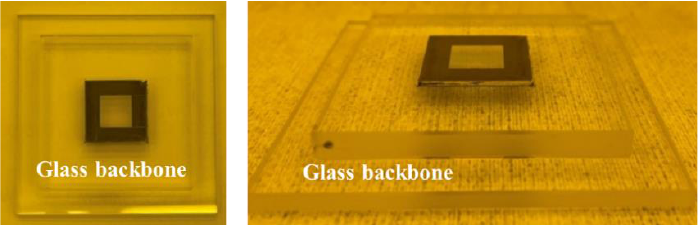
Figure 3. A stamp is attached to the glass backbone, which is required for attachment of equipment.